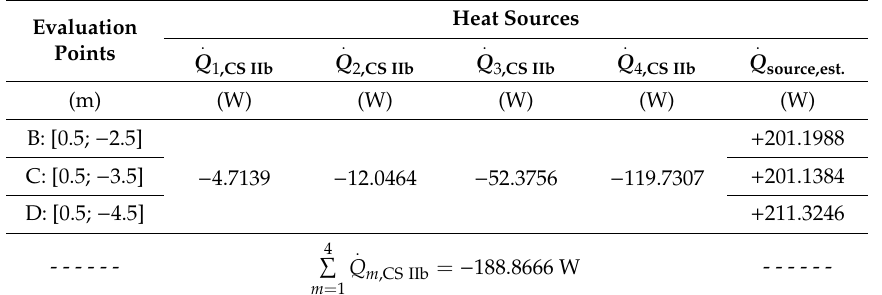
. . Q 2,CS IIb a Q 3,CS IIb for evaluation points B, C, and